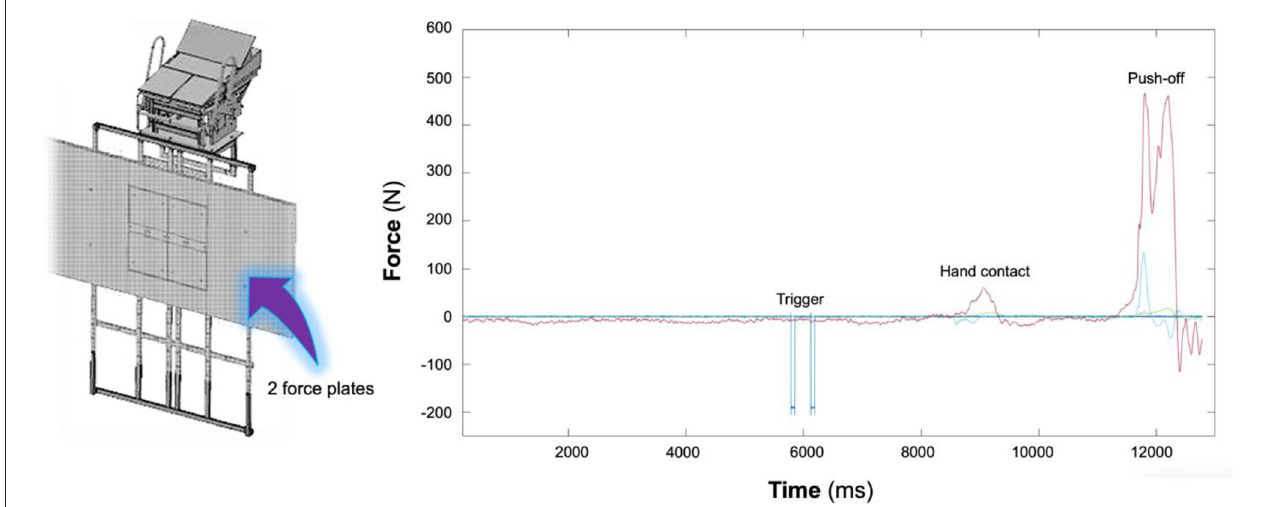
FIGURE 3 | Kinetic data setup and data processing: two triaxial force plates set up and force-time curve of two triaxial force plate profiles (left and right panels). Fx and Fy are the mediolateral (green) and up and down (blue) components, and Fz is the horizontal force component (red).